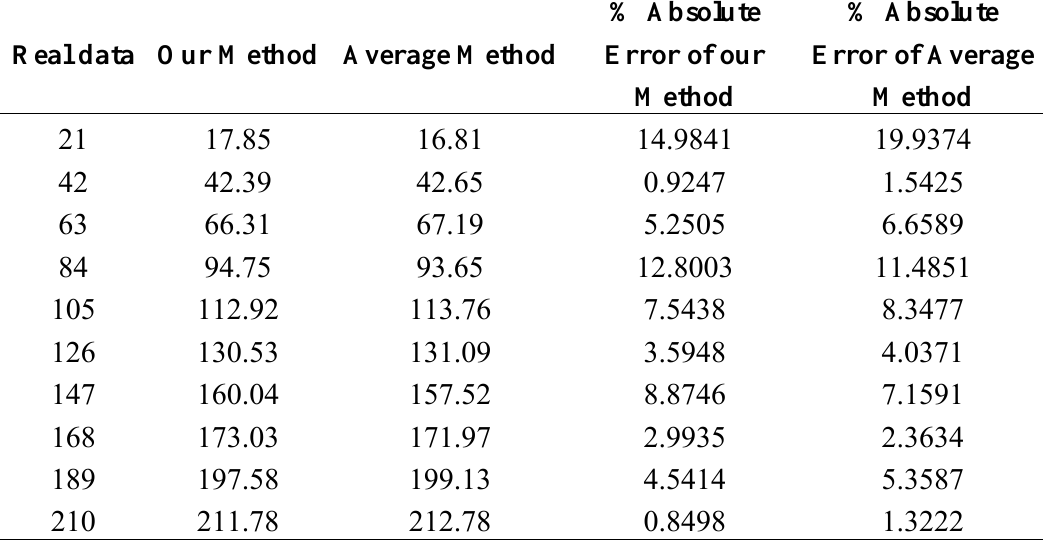
Table 8. Experimental results of